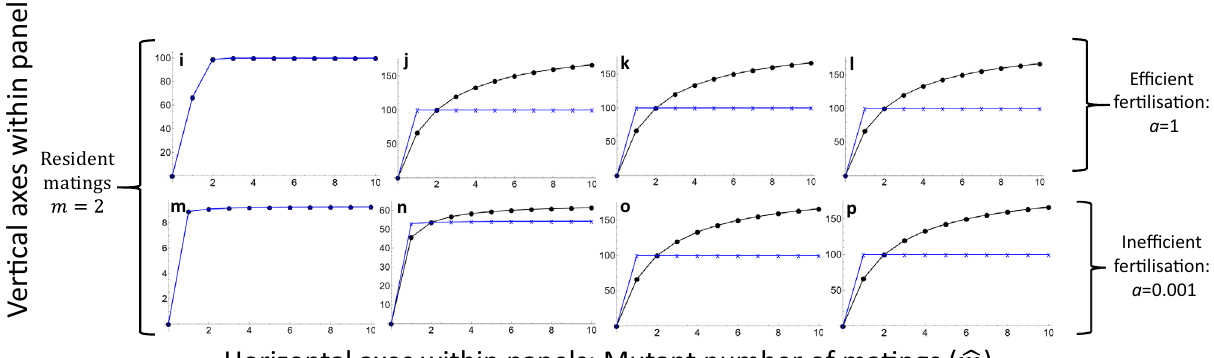
Horizontal axes within panels: Mutant number of ma(cid:2)ngs ( Fig. 2 The Bateman function of Eq. (2) for an externally fertilising population with potential for population-wide polygamy and gamete competition. Results are shown for two values of resident matings ( m = 1 and m = 2). a – h show the effect of variation in sex-speci fi c gamete numbers and in fertilisation ef fi ciency with m = 1, while i – p show the same with m = 2. Parameter values used are shown in the fi gure. The value m = 2 is used here because it is comparable to the mean number of matings in Bateman ’ s 1 work (see Fig. 3 for corresponding results with internal fertilisation, but note that the aim of the models is not to quantitatively reproduce Bateman ’ s results). Females (gamete number n x ) are indicated by blue crosses and connecting lines, while males (gamete number n y ) are indicated by black dots and connecting lines. Under isogamy, females and males are unde fi ned, and the two colours overlap. Further variation in m is examined in Fig.